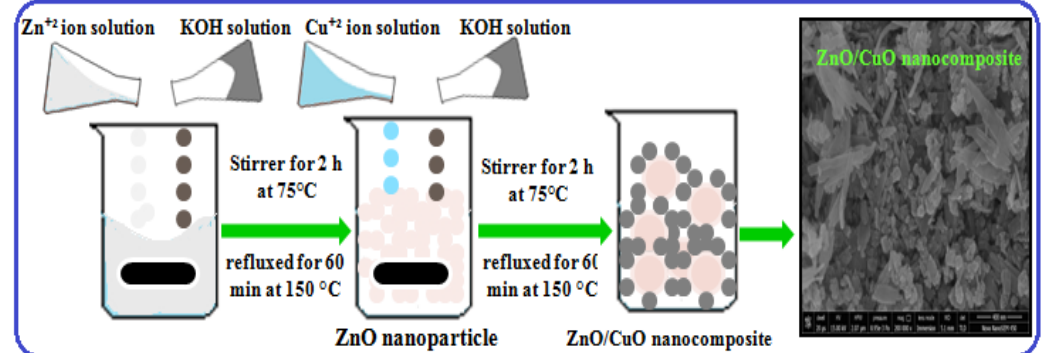
Fig.1. Schematic illustrations of synthesis procedure for ZnO/CuO